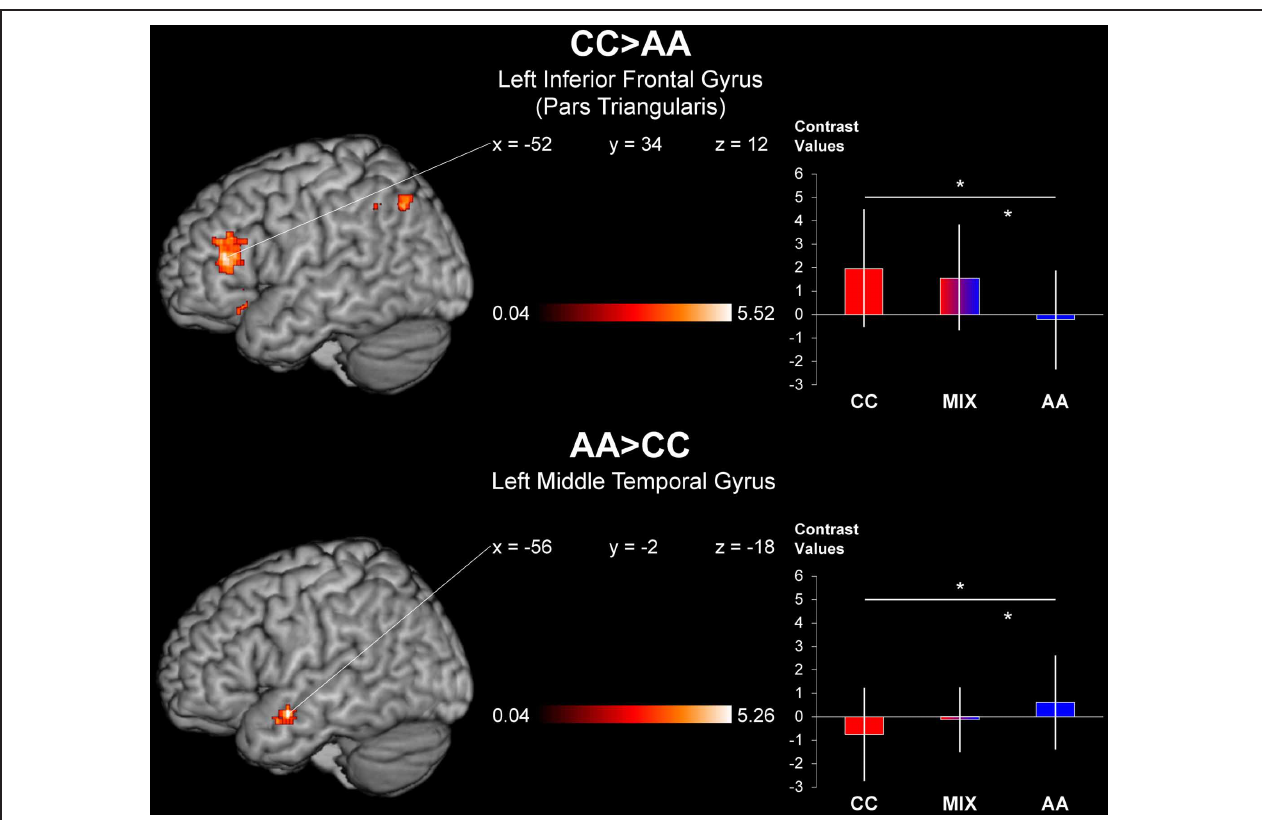
voxels (360mm 3 ), superimposed on the MNI template using the software MRIcron Version 12/2012 (http://www.mccauslandcenter.sc.edu/ mricro/mricron/index.html). The contrast values were extracted from the individual beta images and are depicted as group mean with standard deviation of the mean. Asterisks indicate statistical differences of post-hoc paired t tests ( p < 0 . 05, Bonferroni-corrected for multiple comparisons).